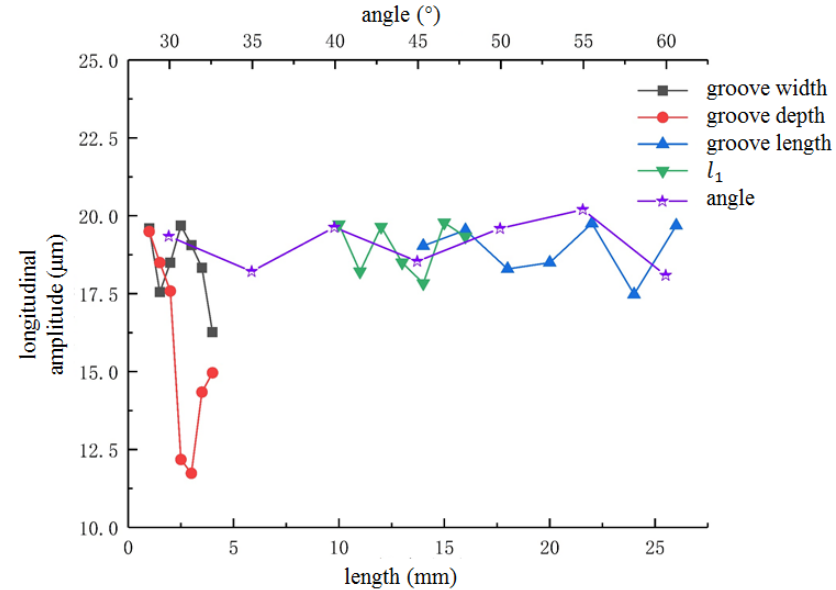
Figure 6. Effect of spiral groove parameters on longitudinal vibration.